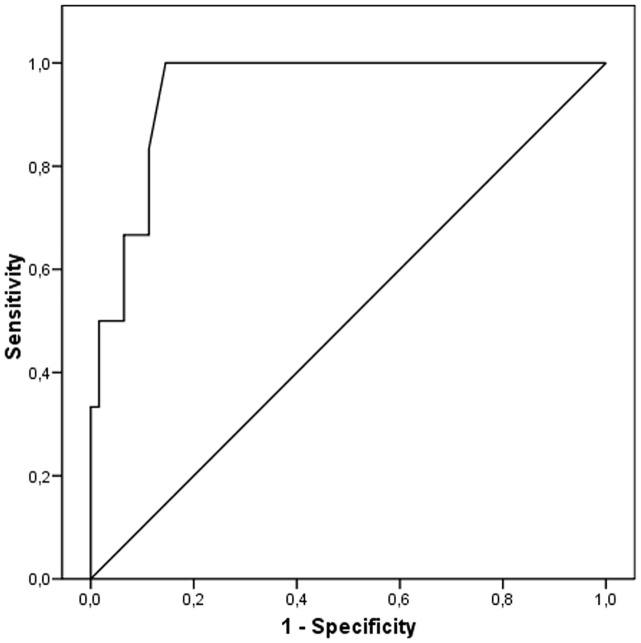
ROC curve on number of VEBs and major cardiac events (considered as sudden cardiac death or ICD implantation). AUROC = 0.92, p<0.0001. ROC = receiver operating curve. AUROC = area under ROC.